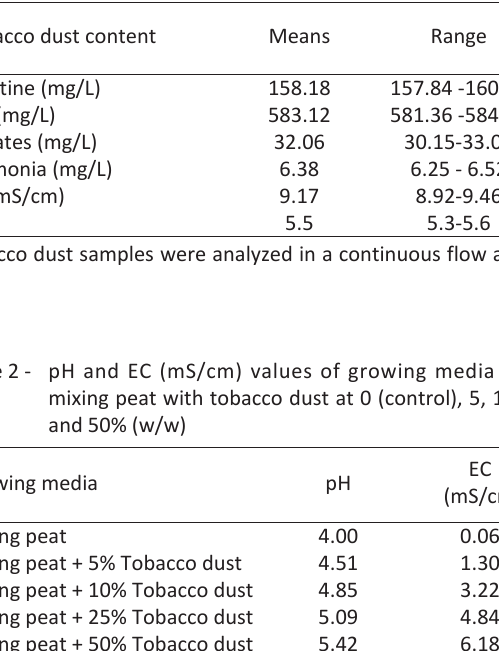
Table 1 - Means and range values of tobacco dust content